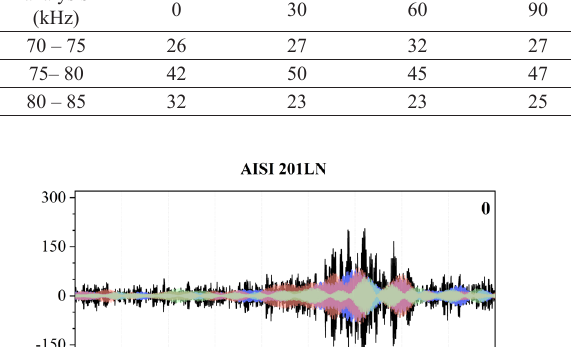
Table 5. Comparative analysis between both materials in relation to the percentage of a small frequency range in the domain near frequency resonance (70-85 kHz). Frequency